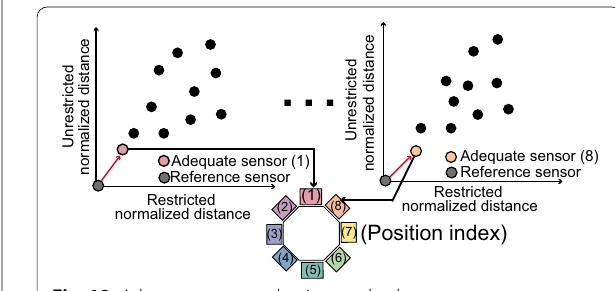
Fig. 17 Comparison of distribution of mutual normalized